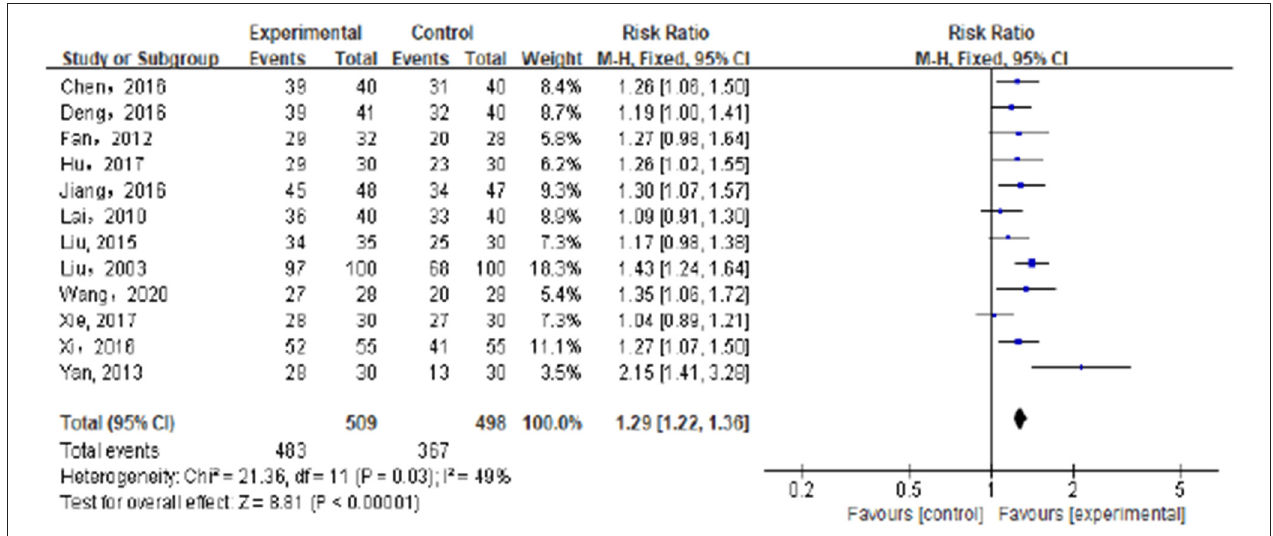
FIGURE 4 | Compared with the control group, the total effective rate of the experimental group was significantly improved.